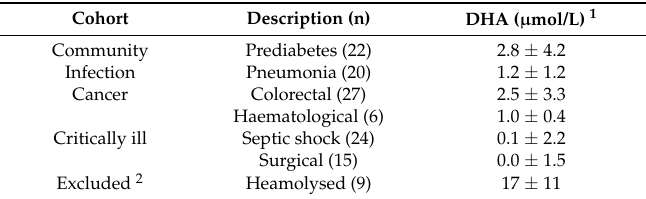
Table 1. Dehydroascorbic acid (DHA) concentrations in clinical